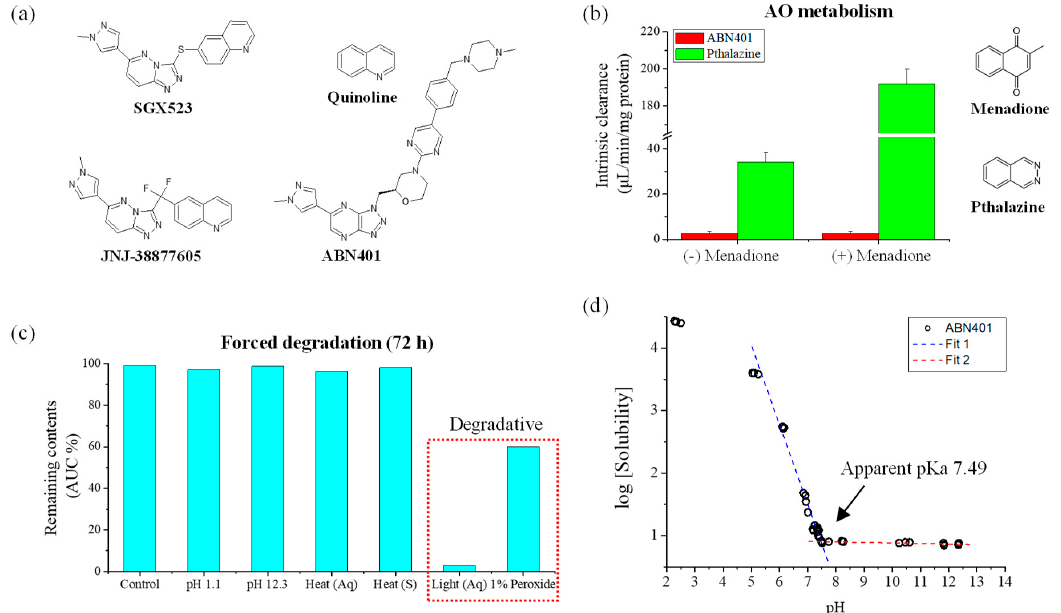
Figure 1. ( a ) Chemical structures of ABN401 and reference compounds. ( b ) Cytosol metabolic stability of ABN401 versus phthalazine. ( c ) Forced degradation result after exposure to different physical stresses. ( d ) pH solubility profile at various pH values.